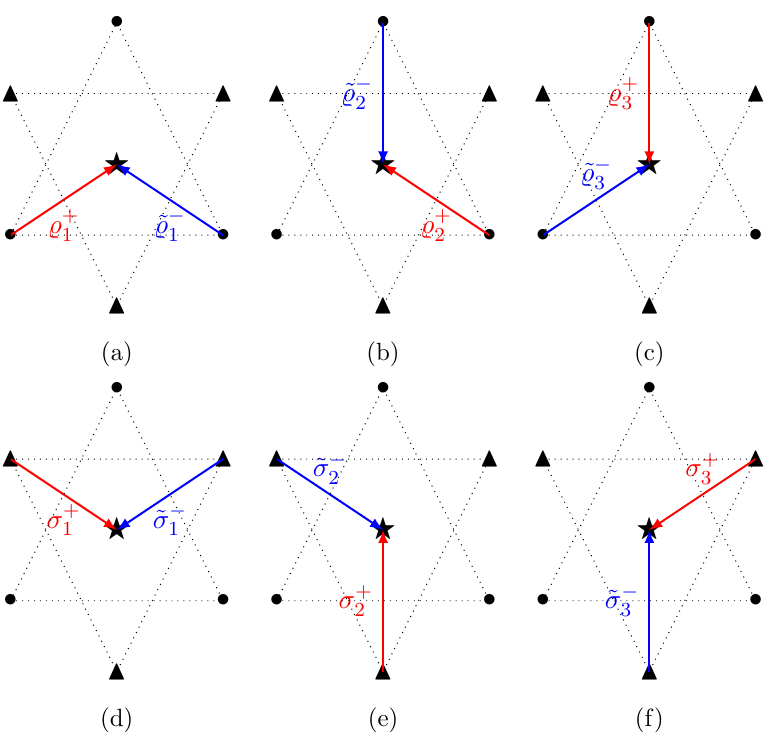
Figure 14. Set-up C [(1 ; 0)] + C [(0 ; 1)] + D . The inter-brane Higgs % , ~ % between C [(1 ; 0)] and point brane D are displayed in (a){(c), while the inter-brane Higgs (cid:27) , ~ (cid:27) between C [(0 ; 1)] and point brane D are displayed in (d){(f).